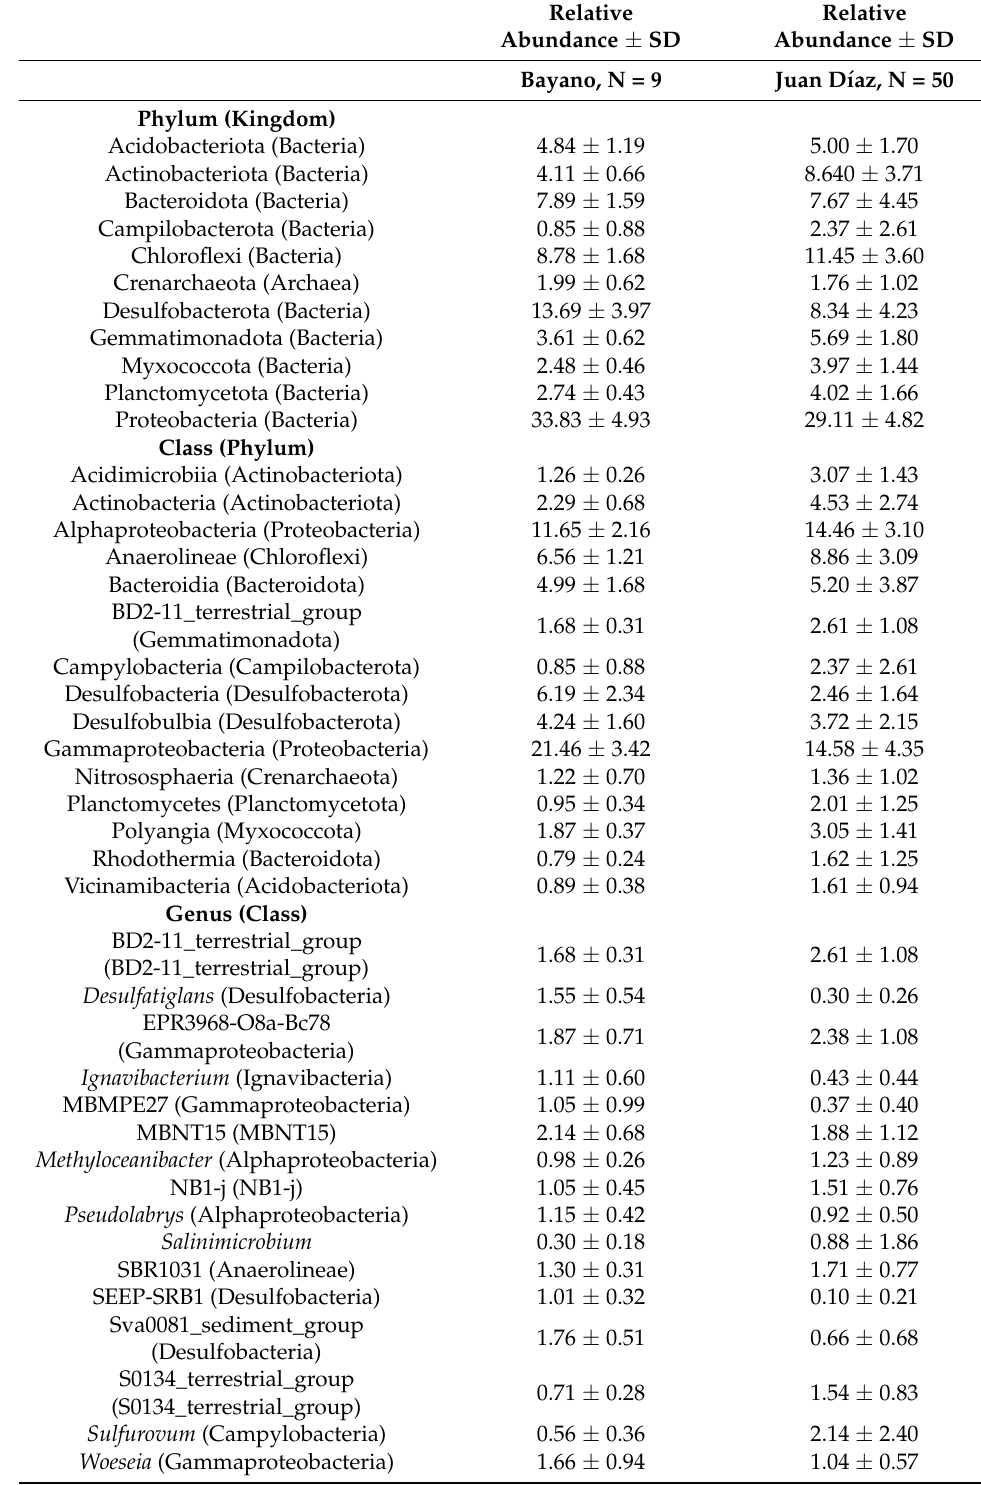
Table 1. Relative abundance (% ± SD) of the most common bacterial taxa associated with both sites, Bayano and Juan D í